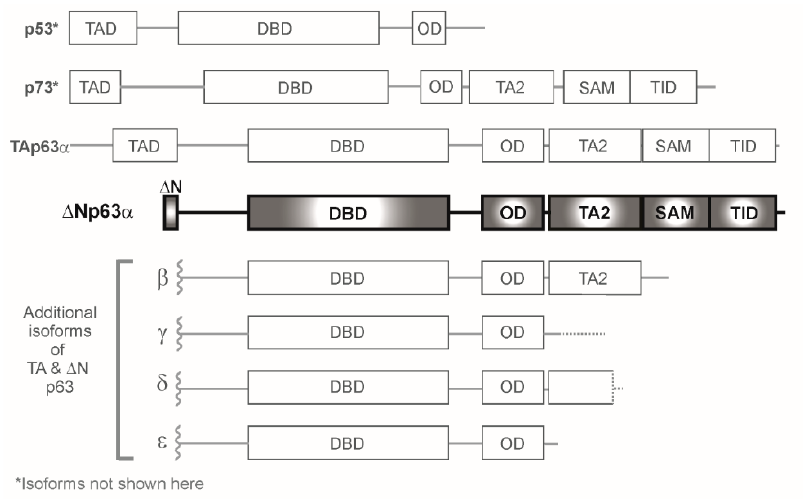
Figure 1. Schematic of p53 / p63 / p73 family members. Within the p63 homologues, alternative promoter usage yields TAp63 and ∆ Np63 subclasses; within each subclass, alternative spicing yields α , β , γ , δ , and ε isoforms. This review focuses on ∆ Np63 α (highlighted), the predominant isoform in